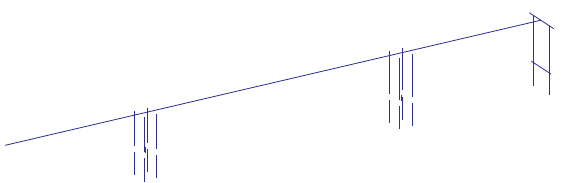
Figure 7: Dynamic finite element model of the